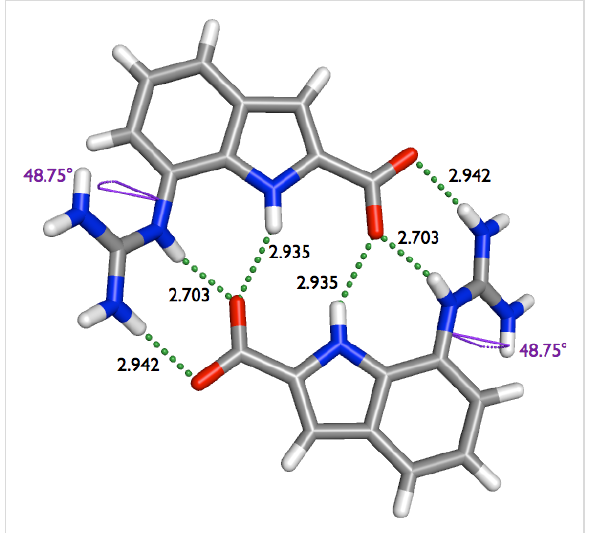
Figure 6: Crystal structure of dimer 2 · 2 with hydrogen bond distances (Å) and dihedral angles.